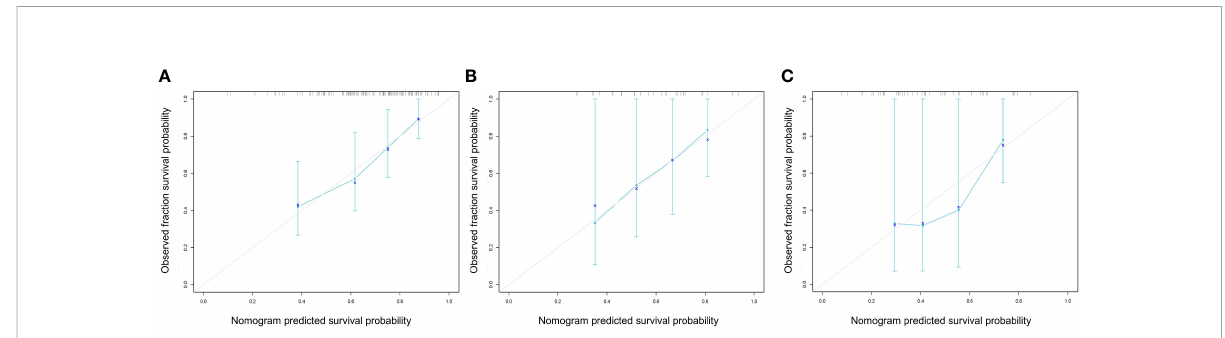
FIGURE 7 Calibration curves of the nomogram model in the training (A) , internal (B) and external (C) cohorts at 1 years for overall survival. These plots graph the observed (y-axis) vs predicted (x-axis) survival probabilities.